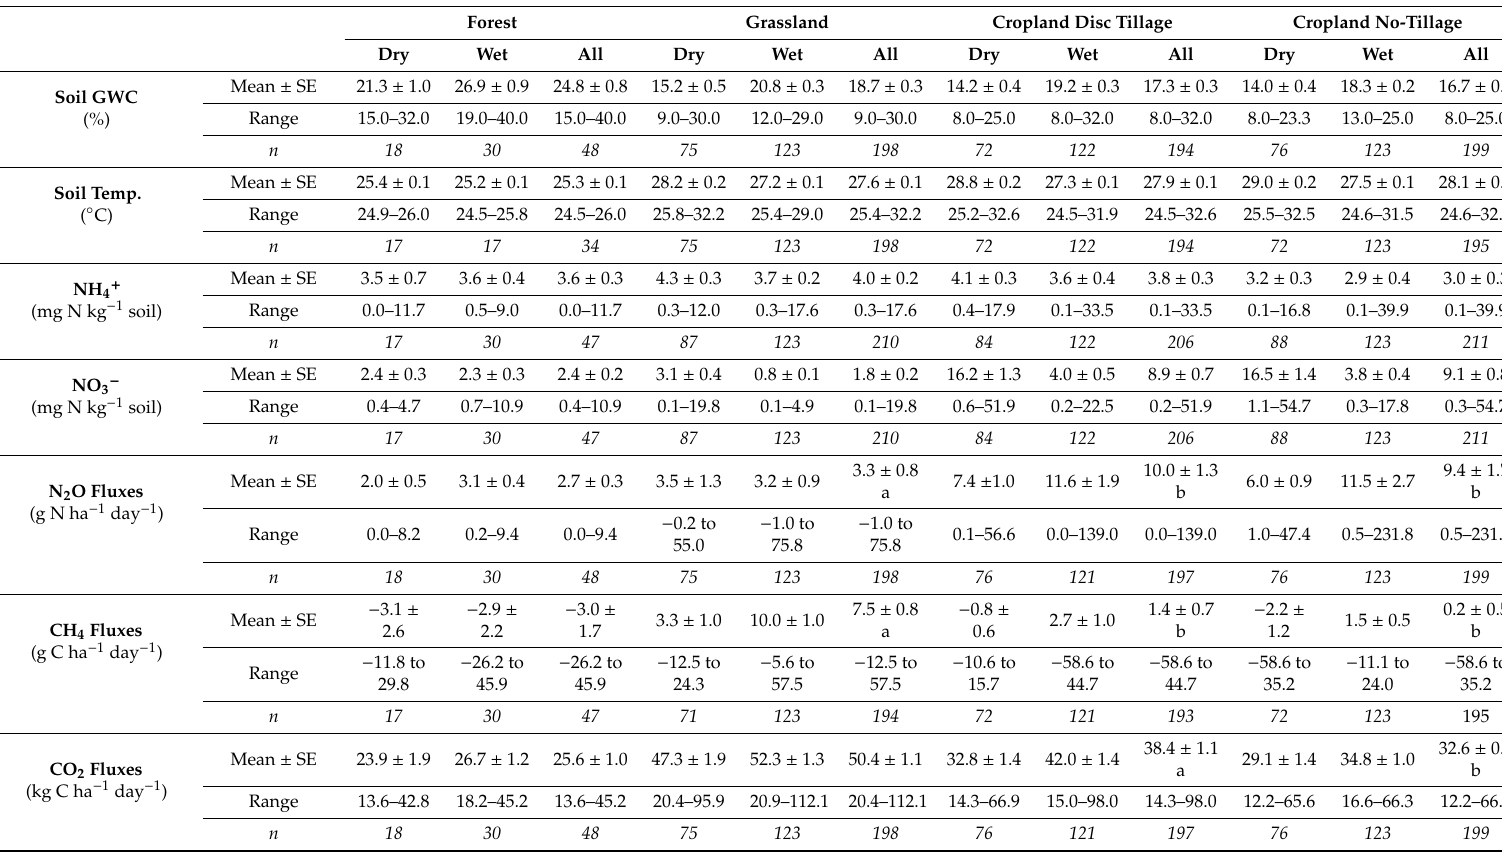
Table 3. Soil parameters and GHG fluxes measured in the three agricultural systems and in the adjacent native forest at the Combi experimental site. Values are computed for dry seasons (monthly rainfall ≤ 150 mm), wet seasons, and all data (from May 2011 to November 2014). n = number of samples (for GHG, samples are the mean per plot). GWC = gravimetric water content, Temp. = temperature. For each GHG flux, means followed by the same letter did not di ff er significantly (ANOVA, p -value <